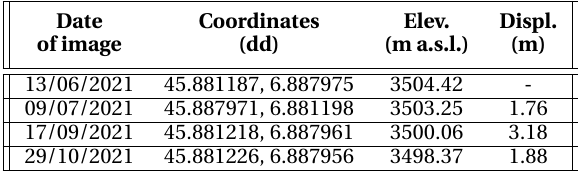
Table 2. dGNSS survey readings.